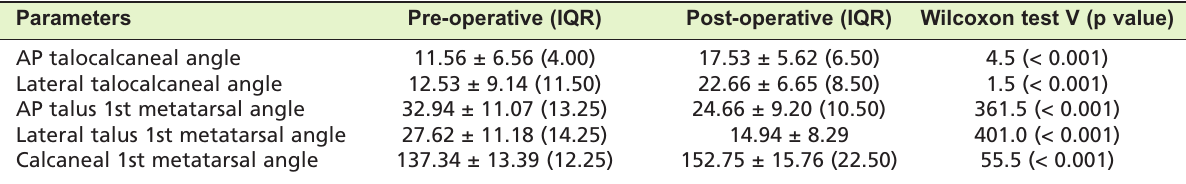
Radiographic parameters, pre-operative as well as post-operative Table III: